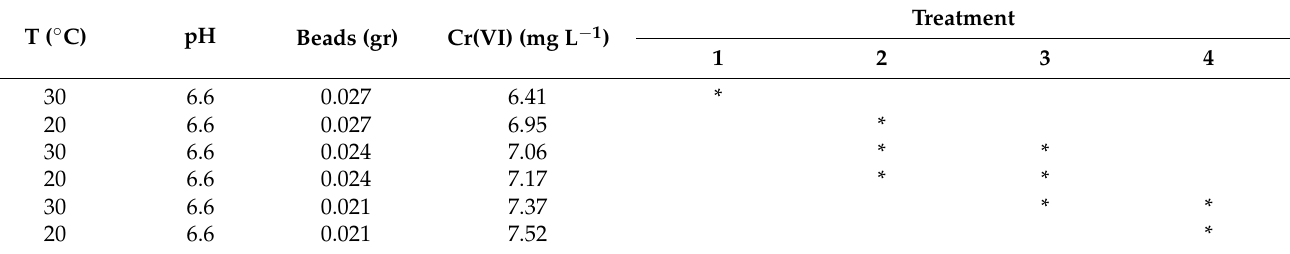
Table 4. Fisher test to find the best biosorption